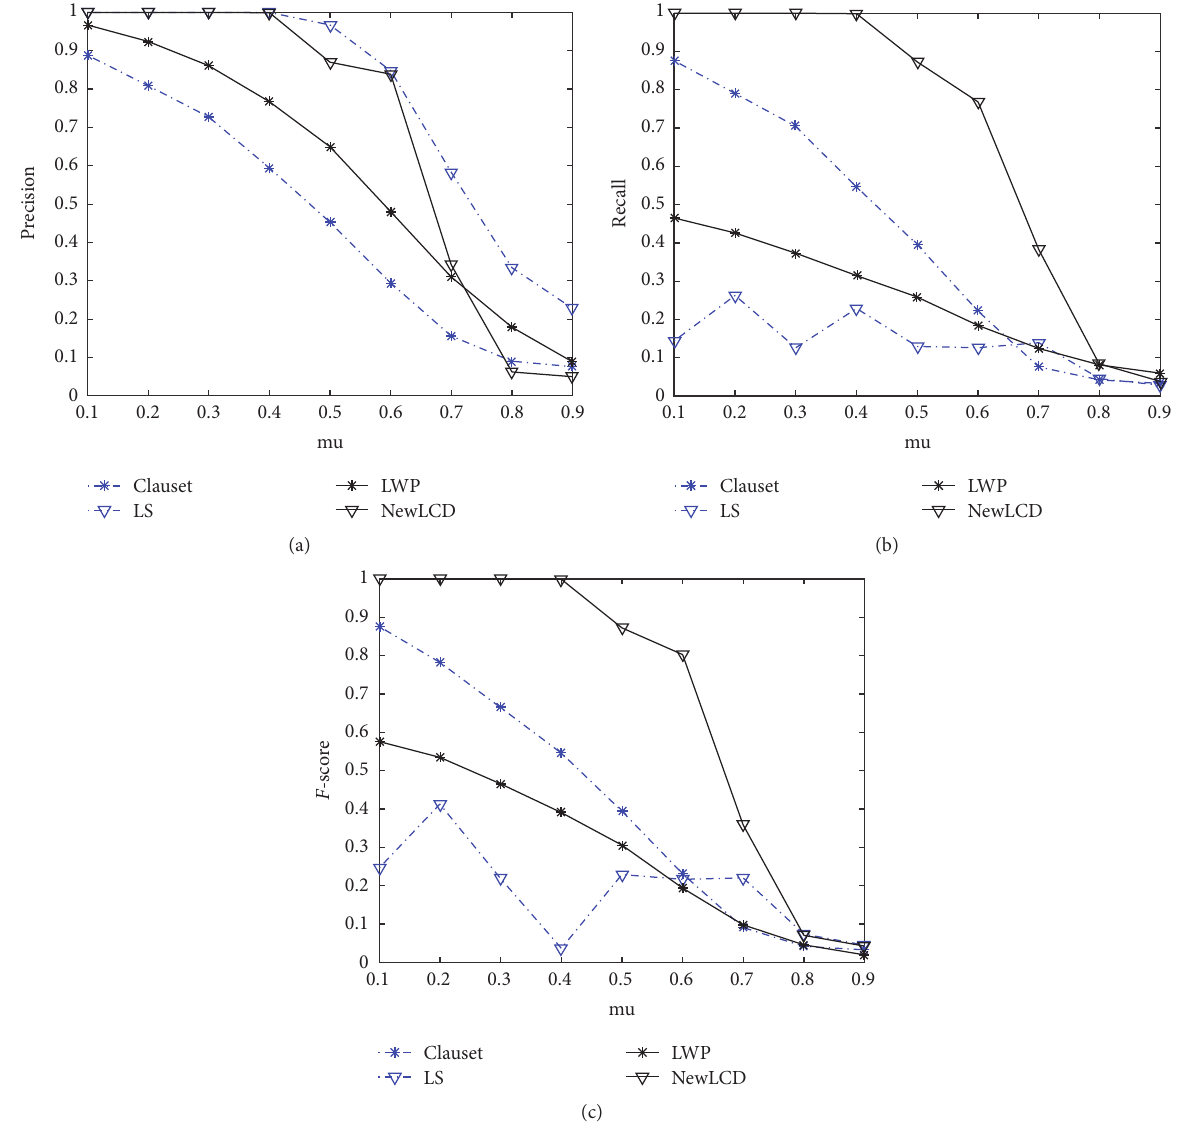
Figure 6: Comparison of